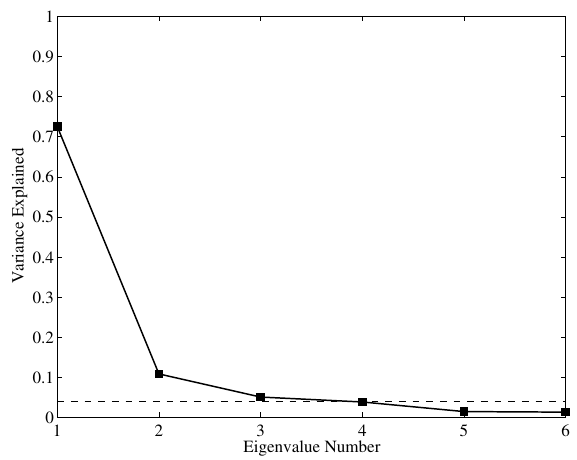
Fig . 6. – variance explained by the first six eofs for the monthly 95 th percentile sWH. the grey dotted line corresponds to the 0.95 cumulative explained variance. only eofs with explained variance above this line were selected for the analysis.